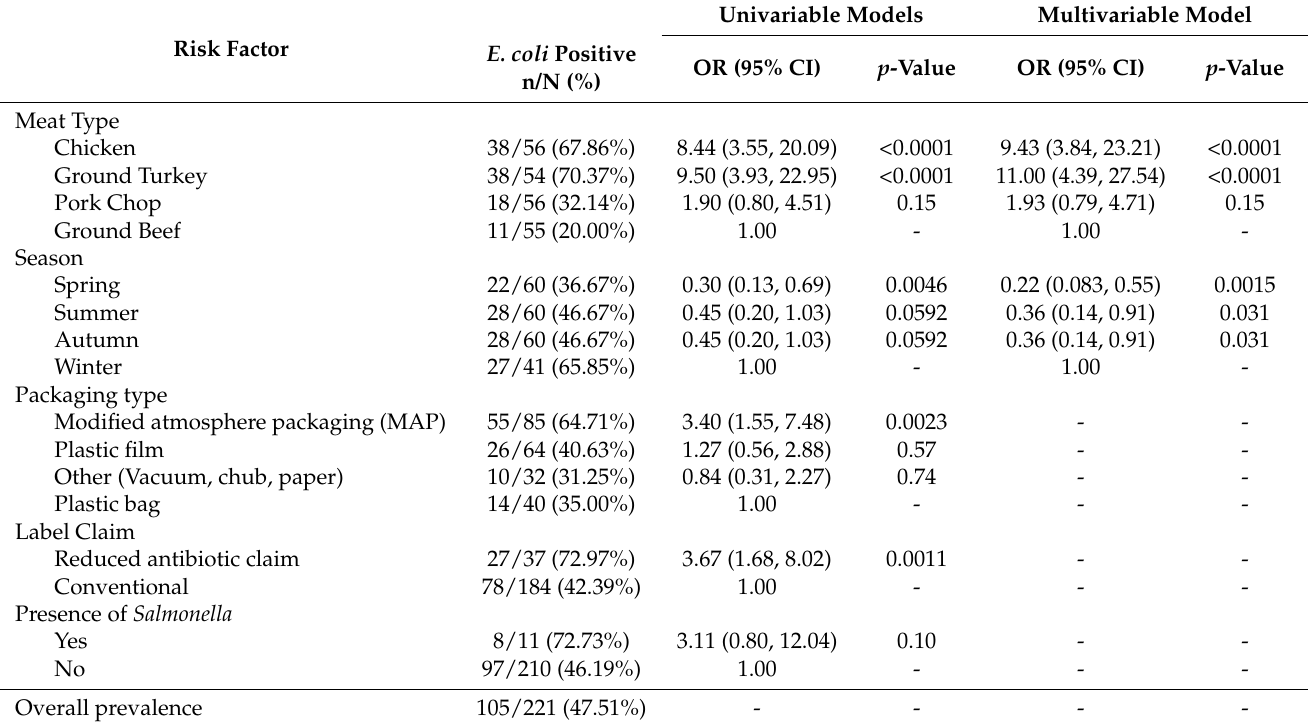
Table 1. Risk factors for presence of E. coli in retail meat products from southern